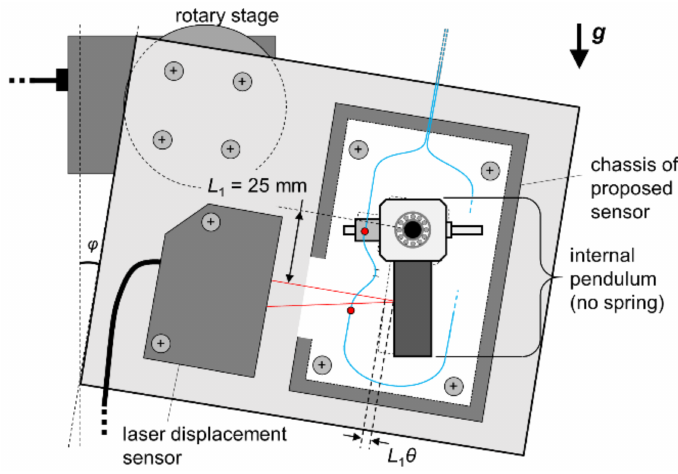
Figure 3. Experimental setup for hetero-core fiber sensitivity to the rotation of a pendulum in the inclined